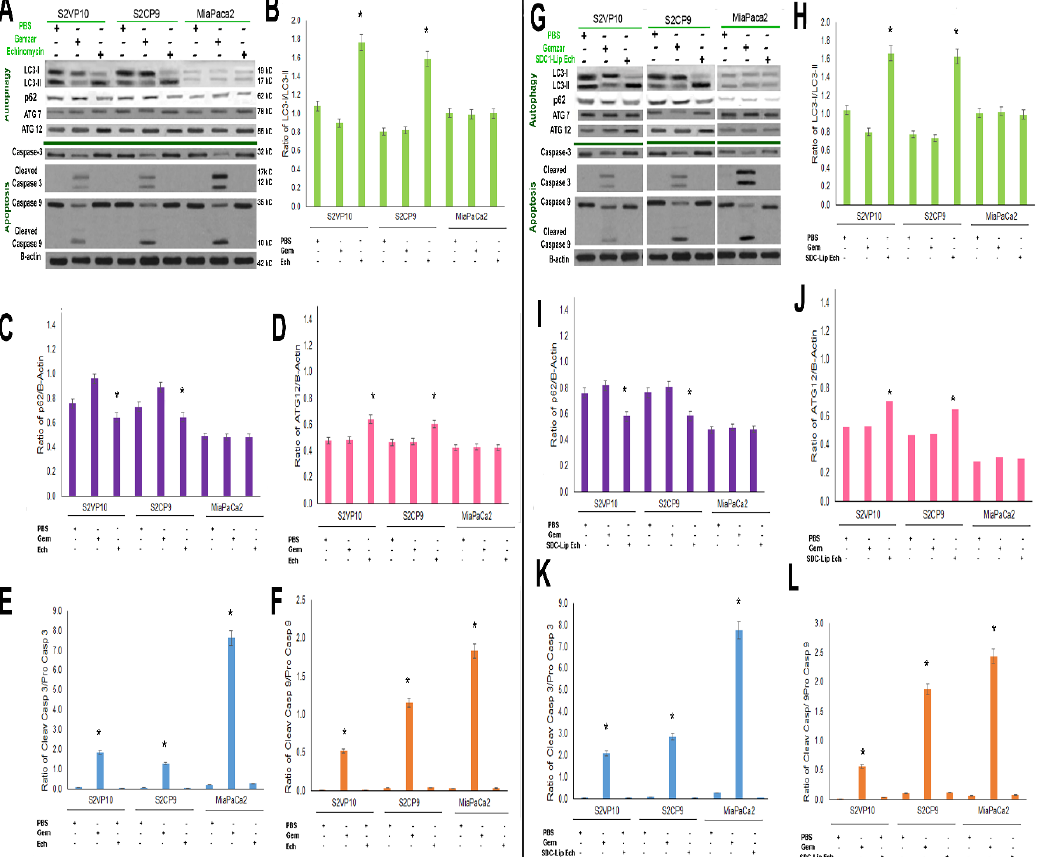
Figure 3. Mechanistic evaluation of SDC1-Lip echinomycin-induced autophagic (non-apoptotic) cell death using Western blot. As observed in Figure 2A,B, SDC1-Lip echinomycin induced cell death. To evaluate potential mechanisms of cell death, S2VP10, S2CP9, and Miapaca2 cells were treated with